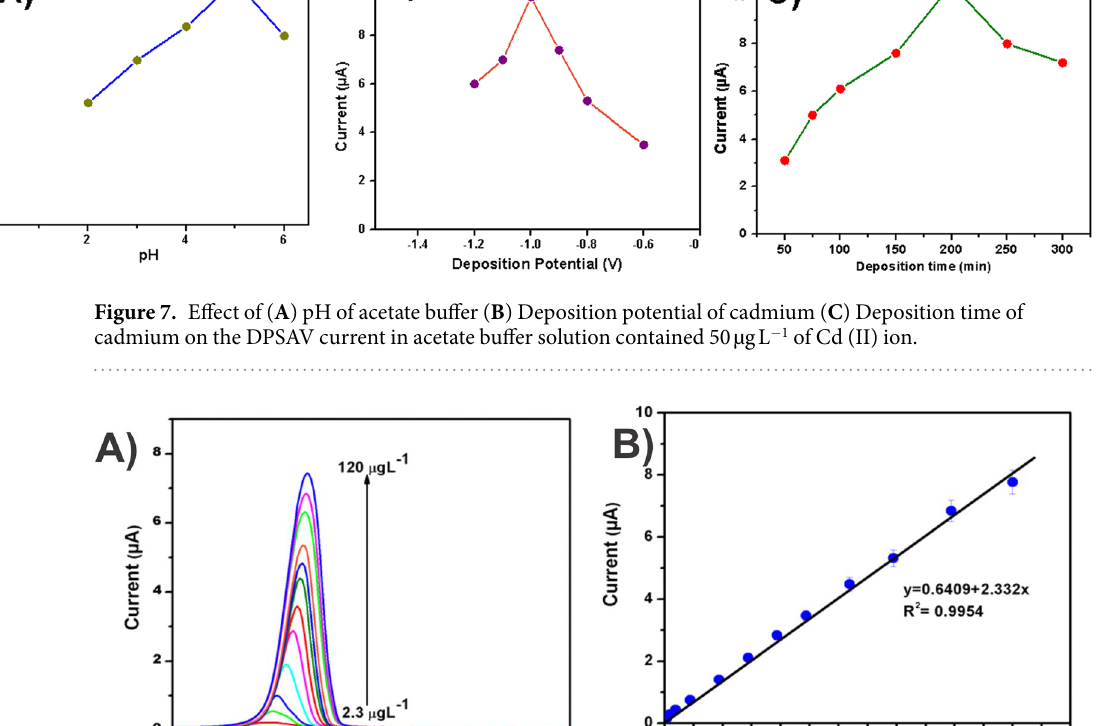
Modified electrode